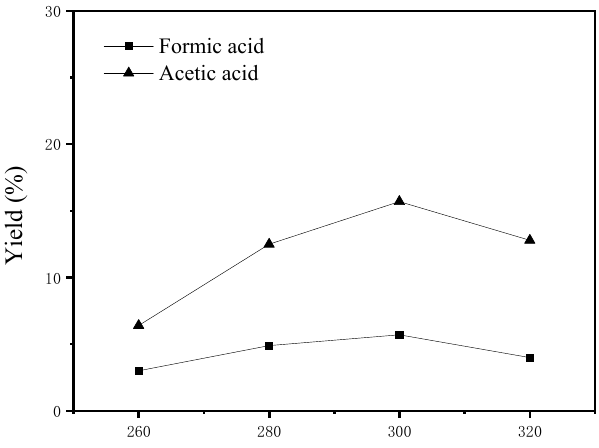
Figure 3. Effects of reaction temperature.